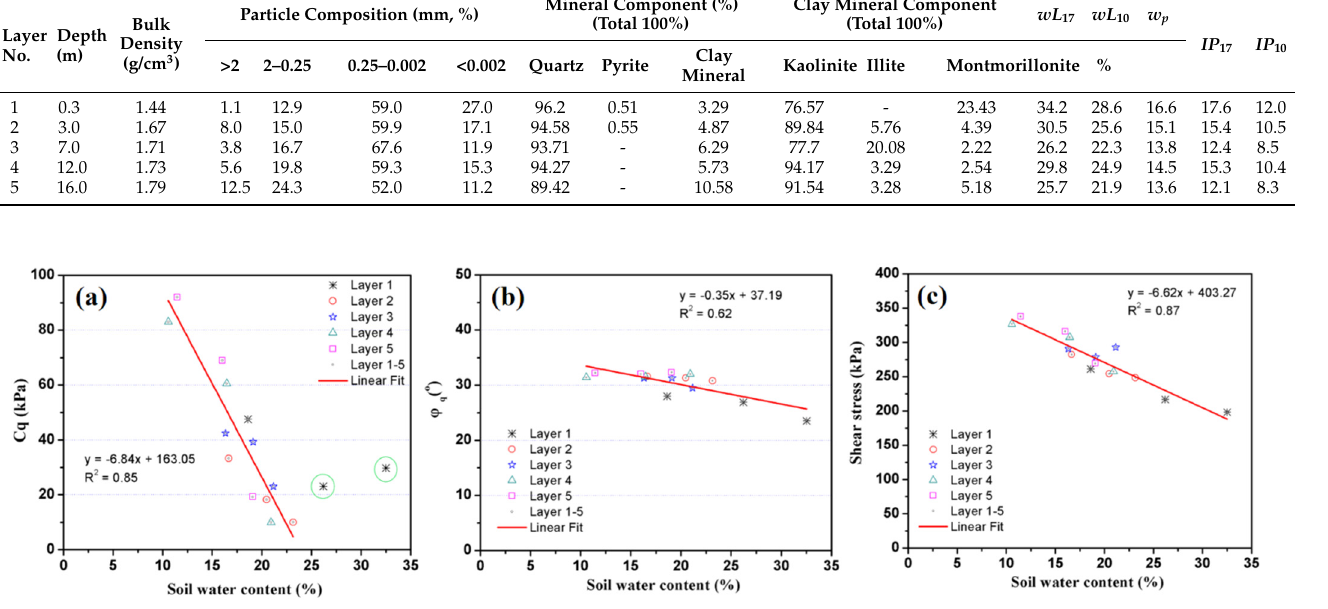
Layer 2 (4.81%) > Layer 4 (3.66%). The magnitude of the maximum and minimum SSR values decayed with each cycle.